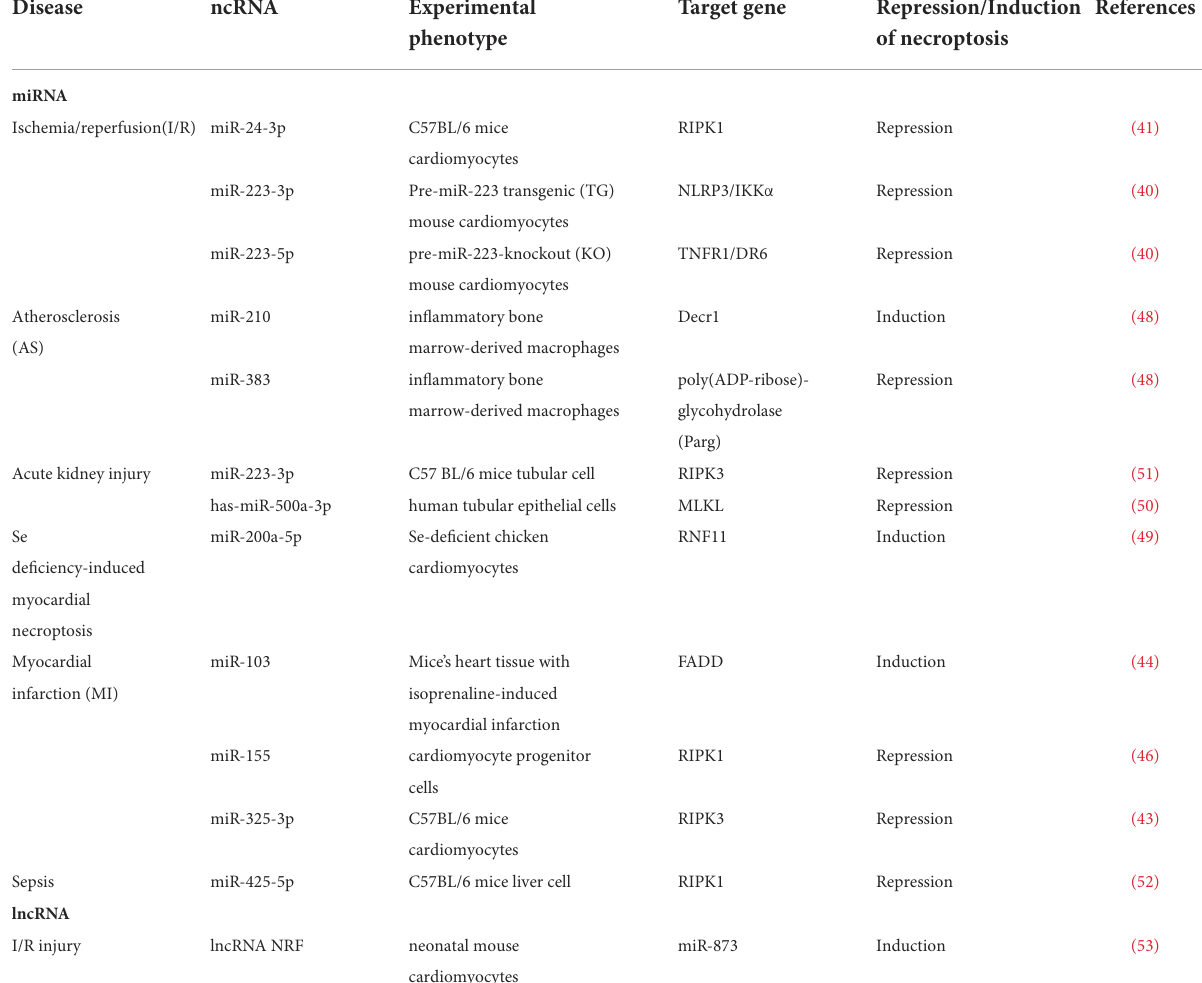
TABLE 1 Non-coding RNAs regulate necroptosis in various type of CVDs.